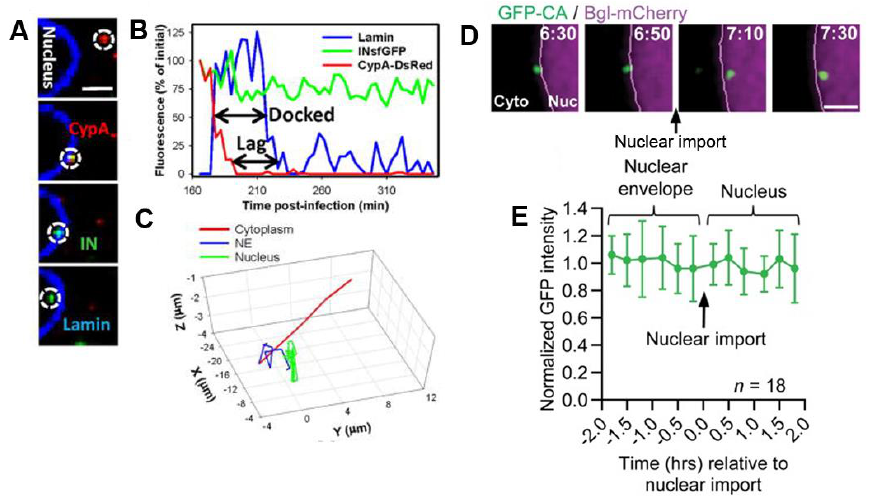
Figure 4. Two conflicting examples of uncoating studies based on live-cell imaging of the loss of capsid labeling. ( A ) Imaging of uncoating at the nuclear pore by time lapse imaging of HeLa-derived cells expressing EBFP2-Lamin and infected with INsfGFP/CypA-DsRed-labeled HIV-1 pseudoviruses. The red signal (CypA-DsRed) is lost upon nuclear entry. ( B ) Fluorescence intensity time trace and ( C ) trajectory of a viral particle revealing the capsid loss during docking at the nuclear envelope characterized by confined movements (reproduced with permission from [13], copyright 2018, Cell Press). ( D ) Time lapse images of CA-eGFP labeled viral particles in HeLa cells expressing BglG-mCherry (located in the cell nucleus) from 6.5 h.p.i. to 7.5 h.p.i. (scale bar 2 µ m) ( E ) The normalized mean intensity time trace of CA-eGFP from the viral particle indicate that most CA-eGFP molecules remain associated with the viral core upon nuclear entry (reproduced with permission from [18], copyright 2020,